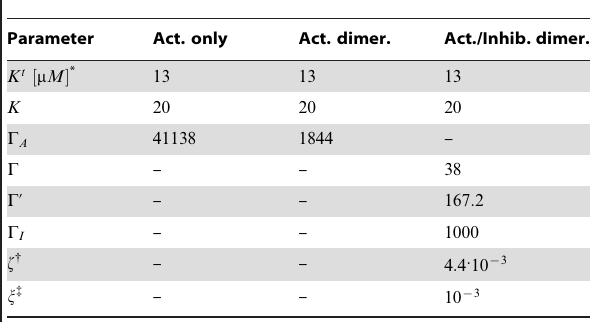
Table 2. Plant roots: parameters.